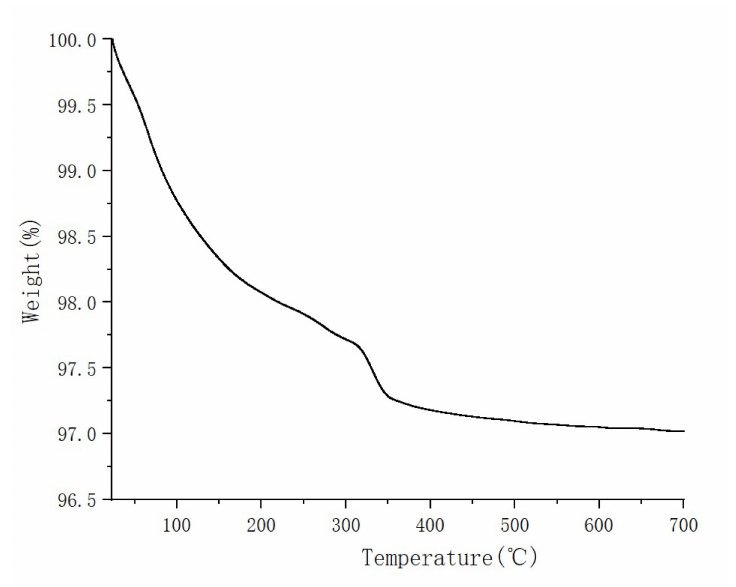
Figure 2. Thermogravimetric analysis of catalyst